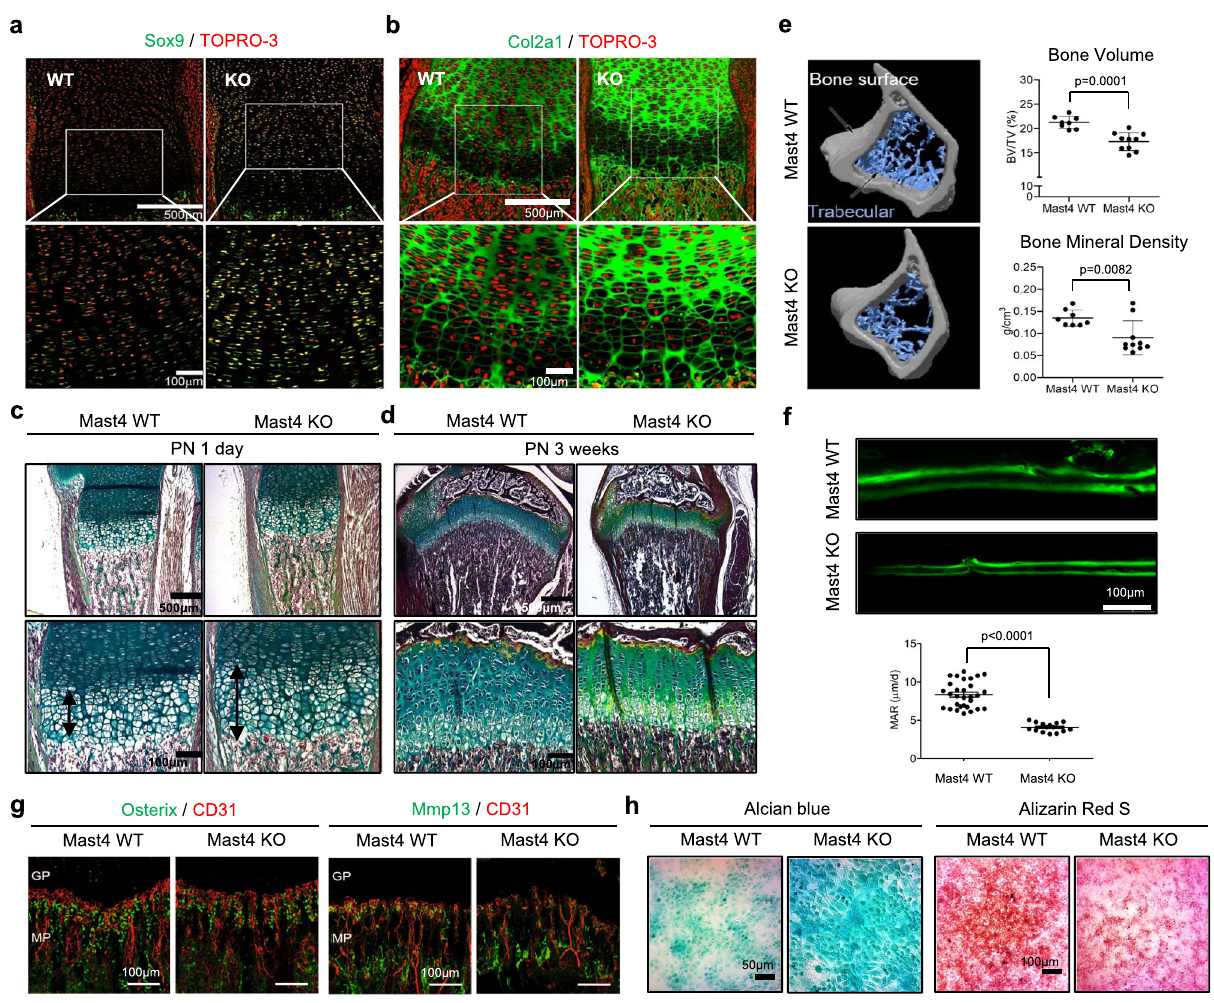
Fig. 5 Mast4 depletion induces altered chondrogenesis and osteogenesis during development. a , b Immuno fl uorescence images of Sox9 and Col2a1 in the growth plate of Mast4 + / + and Mast4 − / − mice at PN 1 day ( n = 3). c , d Pentachrome staining of the tibial growth plates of the ( c ) 1-day-old and ( d ) 3- week-old Mast4 + / + and Mast4 − / − mice ( n = 5). Black arrows indicate the hypertrophic zone. e The μ CT images of the trabecular bone in the tibias of Mast4 + / + and Mast4 − / − mice. Total bone volume and bone mineral density (BMD) of trabecular bone were measured from the μ CT images ( n = 8 for Mast4 + / + and 10 for Mast4 − / − mice). f Bone formation was visualized by double calcein labelling at 7d and 2d prior to sacri fi ce, and the distance between labels were measured at 3 points per tibia ( n = 10 tibias for Mast4 + / + and 5 tibias Mast4 − / − mice). MAR: mineral apposition rate. g Representative images of the immuno fl uorescence staining of Osterix and Mmp13 near metaphyseal blood vessels (CD31) in the proximal tibia of 6-week-old Mast4 + / + and Mast4 − / − mice ( n = 3). GP: growth plate, MP: metaphysis. h Representative alcian blue and Alizarin Red S staining results obtained from in vitro colony formation assay using skeletal stem cells isolated from 5-week-old Mast4 + / + and Mast4 − / − mice ( n = 5). e , f , Data are reported as mean ± SD. Unpaired two-tailed Student ’ s t test ( P < 0.05) was conducted for all statistical analyses. Source data for e , f are provided as a Source Data fi between bone and cartilage (Supplementary Fig. 25b), suggesting the functional involvement in MSC differentiation. Gene set better understanding of the role of Mast4 in MSC differentiation, enrichment analysis for DEGs also revealed that signi fi cant we conducted RNA sequencing by collecting and combining numbers of DEGs in cartilage were assigned to cartilage devel- RNAs obtained from bone and cartilage of the tibias of Mast4 − / − opment (FDR = 0.001), while DEGs in bone were assigned to mice at PN 1 day with those of wild-type mice (3 mice per each skeletal system development (FDR = 0.004) and Wnt signaling group). Differentially expression (DE) analysis exhibited tissue- pathway (FDR = 0.002) (Fig. 6a, b). Particularly, most of Sox9 speci fi c expression with 175 up-regulated (CL1) and 181 down- target genes were up-regulated in cartilage of Mast4 − / − mice, but regulated (CL2) genes in bone, and 108 up-regulated (CL4) and not in bone. A network of Sox9 and Runx2 target genes showing 327 down-regulated (CL5) genes in cartilage of Mast4 − / − mice differential expression in cartilage and/or bone of Mast4 − / − mice (Supplementary Fig. 25a). Gene ontology (GO) enrichment were analyzed. These Sox9 and Runx2 targets were highly inter- analysis revealed the high association with skeletal system acted with the genes related to skeletal system development, development (D in Supplementary Fig. 25b; represented by CL2, including cartilage and bone development, TGF- β signaling, BMP CL3, and CL4; P = 4.5×10 − 8 ~9.3×10 − 4 ). Remarkably, 17 of the 120 common differentially expressed genes (DEGs; CL3), mostly signaling, and Wnt signaling (Fig. 6c). Genes related to cartilage identi fi ed as Sox9 target genes that are cartilage-speci fi c for ske- development were highly interacted with Sox9 target genes (i.e. letal system development, showed distinct switches in expression Tgfb1 , Bmp7 and Bgn ; DE in cartilage). However, genes related to